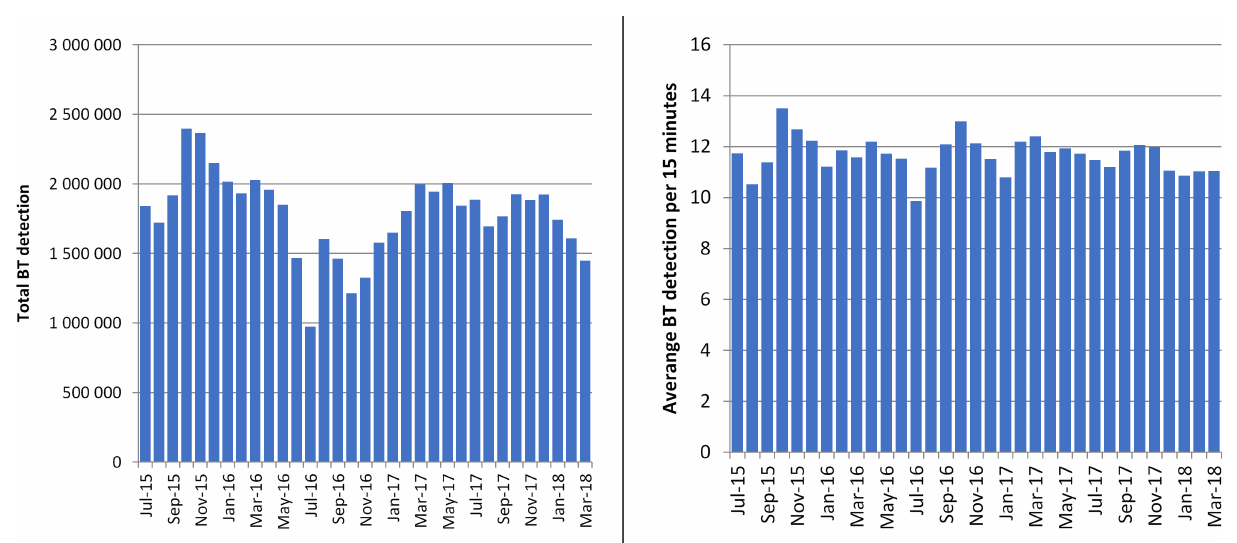
Figure 8: Total BT detection and average BT detection per 15 minutes in the area of